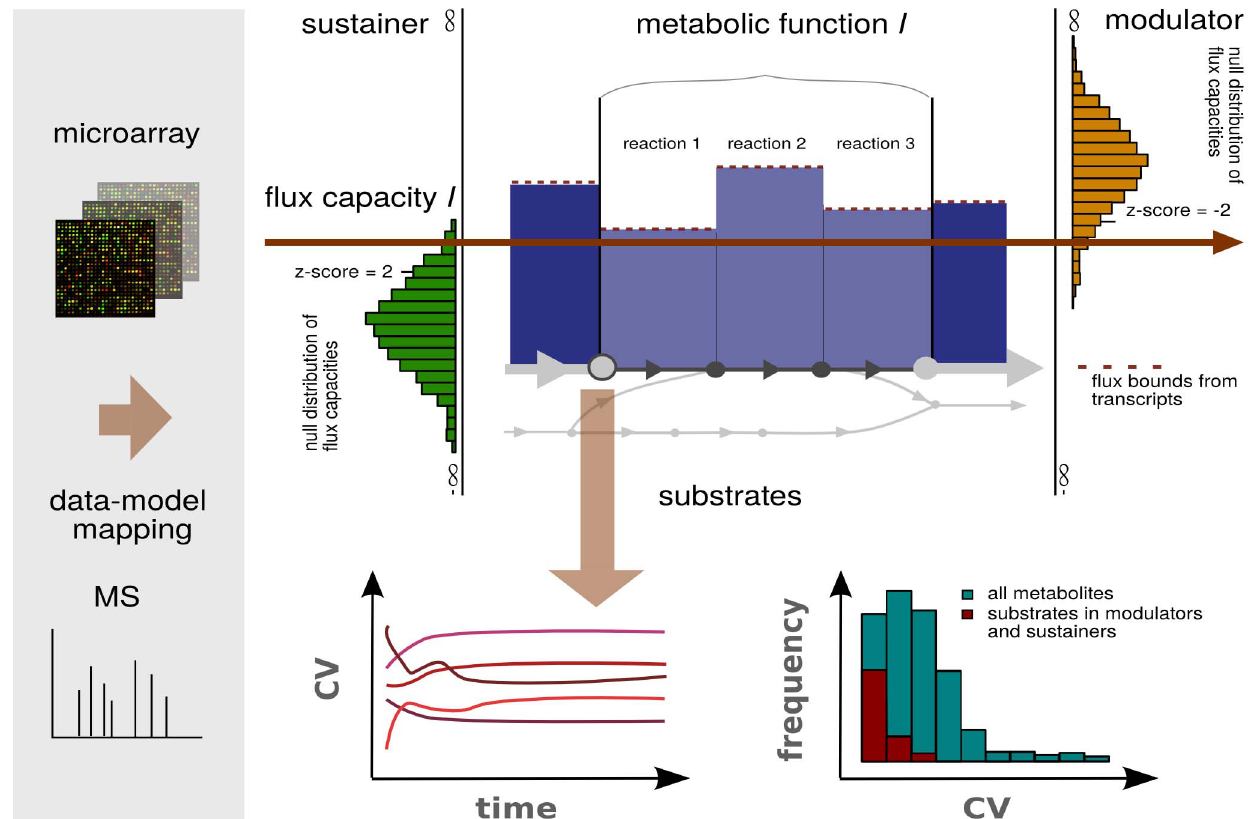
Figure 1. Schematic representation of the analysis framework. Transcriptomics and metabolomics data capturing Arabidopsis thaliana ’s temporal response to eight different environmental conditions (combinations of different light and/or temperature regimes) are collected for a time- series of 24 hours. The transcriptomic data are used to constrain flux boundaries of the respective reactions in a large-scale network by assuming a correlation between the transcript abundance and the upper flux boundary through the respective enzyme-catalyzed reaction. Based on a model with randomized flux boundaries (null model), pathways are classified as differential for a given condition if they exhibit an absolute z { score w 2. Differentially up-regulated (down-regulated) pathways are termed sustainers (modulators) of the metabolic state, respectively. Independently from this categorization, the temporal variation of the metabolite profiles was determined. Under certain conditions, substrates in the differential pathways exhibit a significantly lower temporal variation with respect to other groups of metabolites.